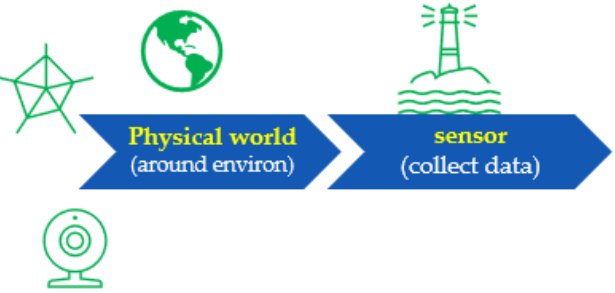
Figure 11. Sensors are the main resource for the collection of data.